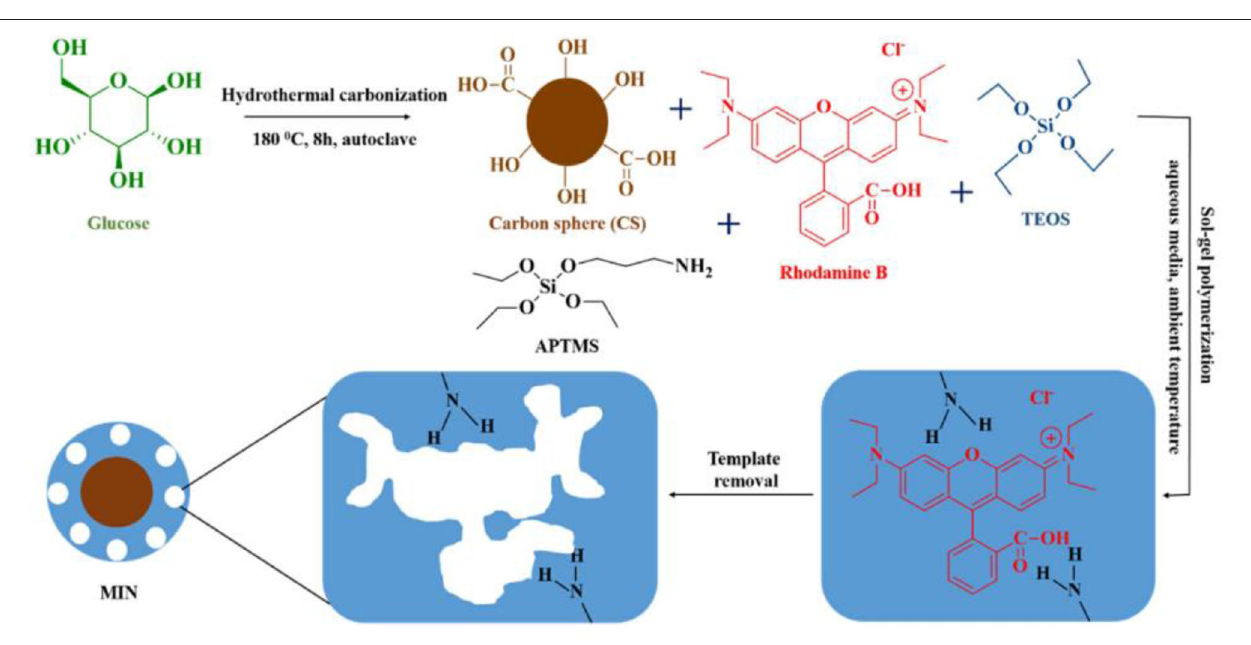
FIGURE 12 | Schematic illustration for the basic preparation procedure of MINs (Arabi et al., 2020a). Reprinted with permission from Elsevier. Copyright (2020)